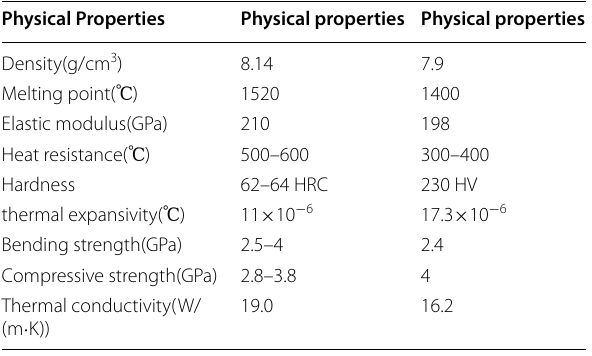
Table 2 Comparison of the physical properties between HSS and stainless steel